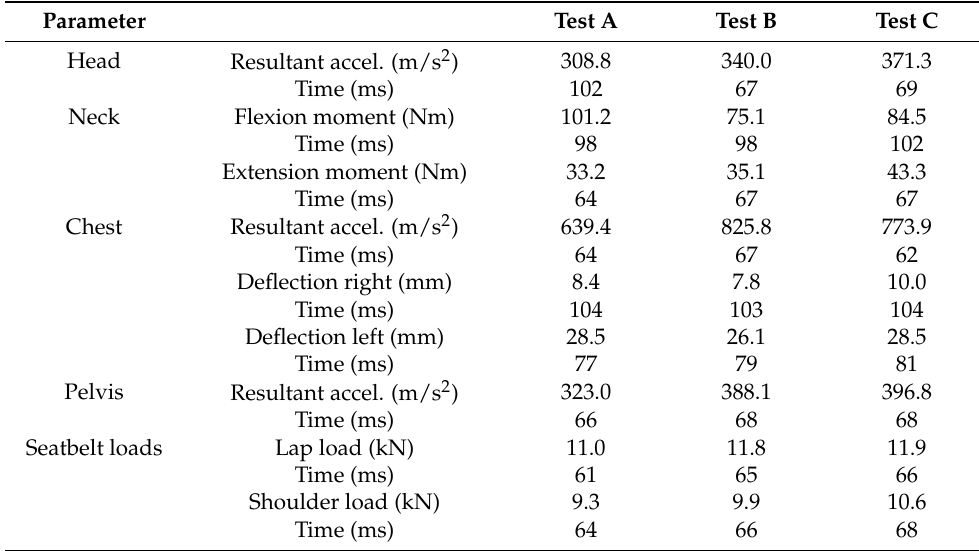
Table 1. Maximum head, chest, and pelvis accelerations, neck flexion and extension moments, chest deflections, and seatbelt loads using the seatbelt arrangements shown in Figure 1 (test A), Figure 2 (test B), and Figure 3 (test C).